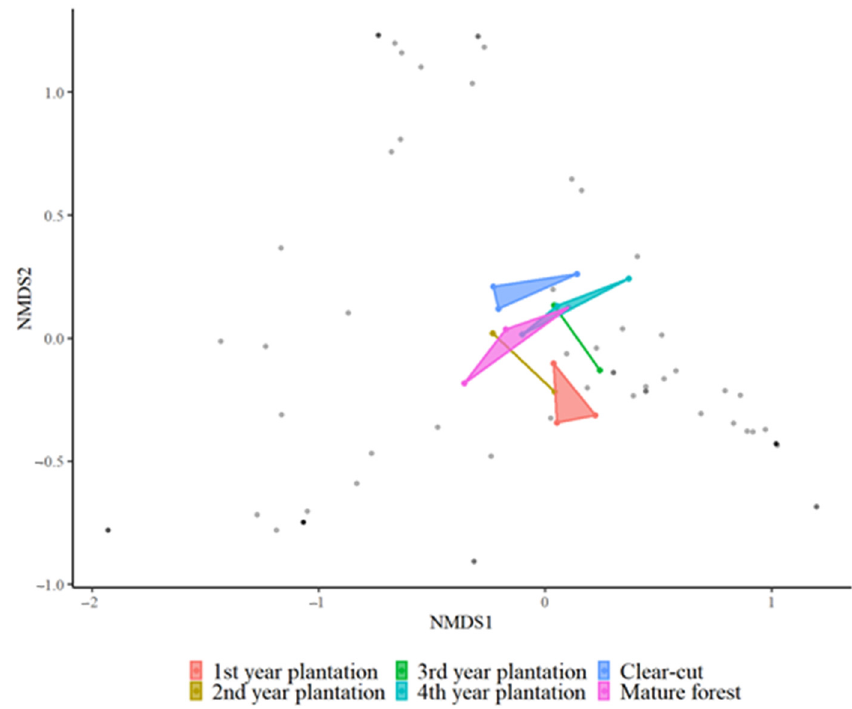
Figure 8. Nonmetric multidimensional scaling (NMDS) ordination of the mycorrhizal fungi abun- dance in study sites (Bray–Curtis index). Each point represents a separate mycorrhizal fungal OTU. The data obtained in three study sites (A, L, and V) were combined to show the overall situation for the mature forest stands, clear-cuts, and reforested 1st–4th year Pinus sylvestris L. plantations. In total, 70 mycorrhizal fungal OTUs were found in the soil samples in the studied sites. The relative abundances of the thirty most common ectomycorrhizal (ECM) fungi are given in Table 5.